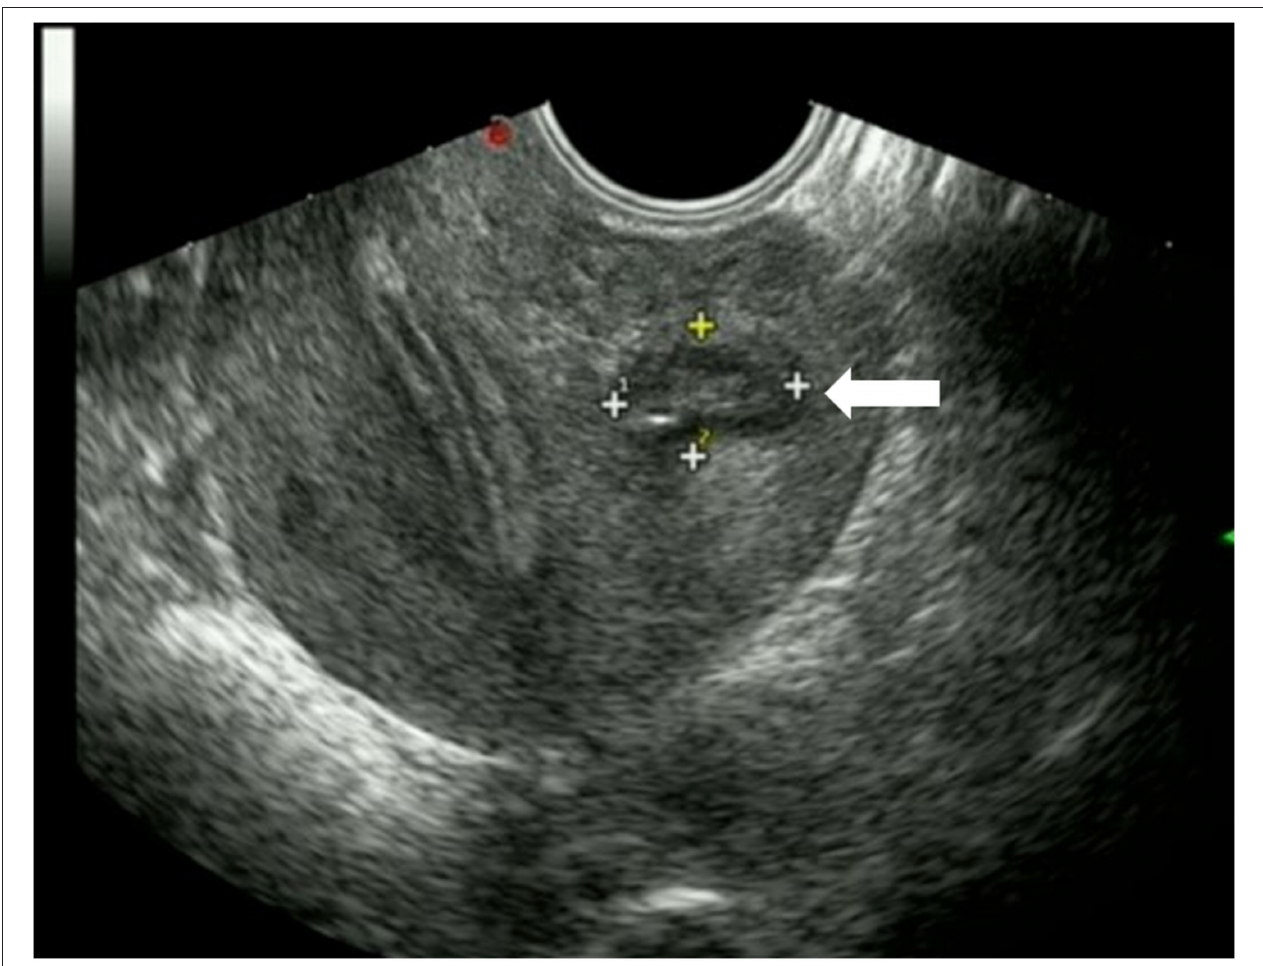
FIGURE 3 | Transvaginal ultrasound showed that the mass (horizontal arrow) was significantly decreased 1 year after operation, with moderate echo and no fluid